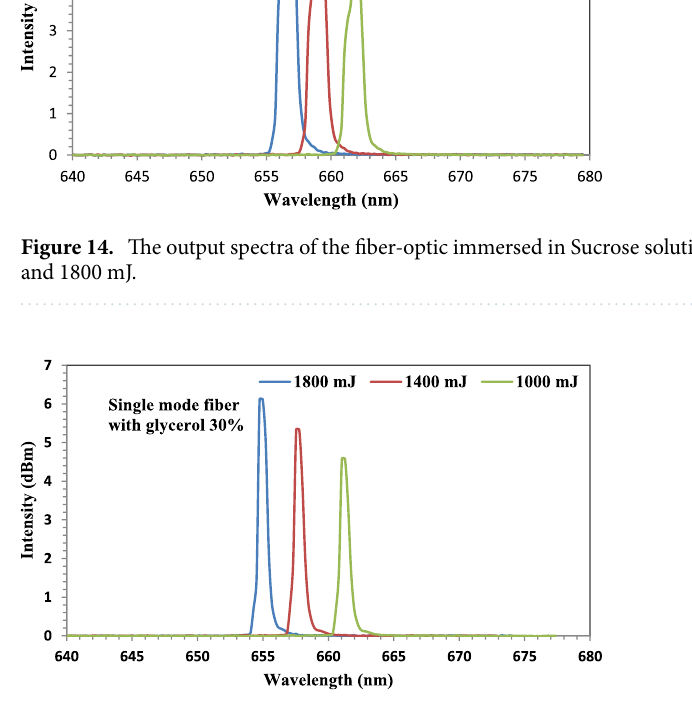
Figure 15. The output spectra of the fiber-optic immersed in Glycerin solution at ablated energies of 1000, 1400, and 1800